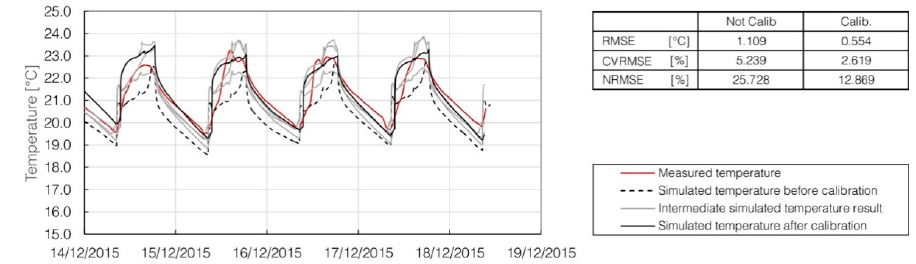
Figure 10. Results from Calibration C. First floor, North-West exposure.